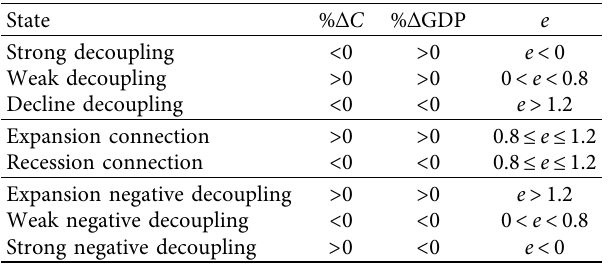
Table 1: Classification of the decoupling status by the Tapio